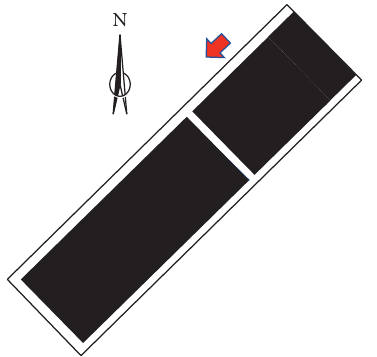
Figure 1: Roadway layout of 27304 working face.